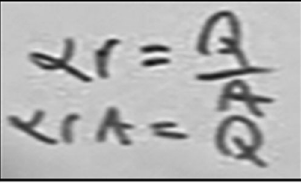
FIG. 5. Percentage of time students were involved in each frame.